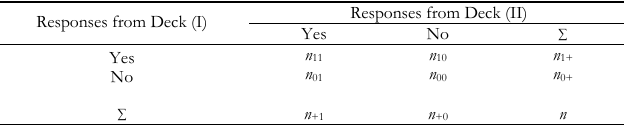
Responses from Deck (II)